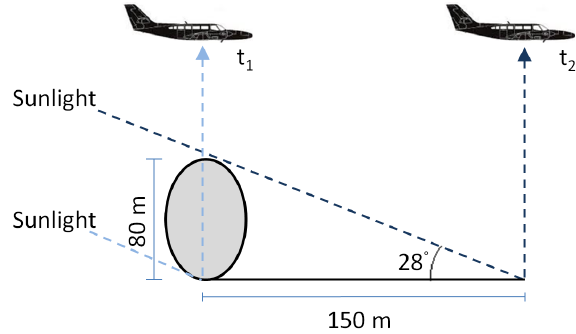
Figure 12. Schematic showing the contribution of solar geometry to the north–south striping seen in the data. Plumes 80m high will produce 150m artefacts on the surface. t 1 and t 2 correspond to two measurement intervals 150m apart.